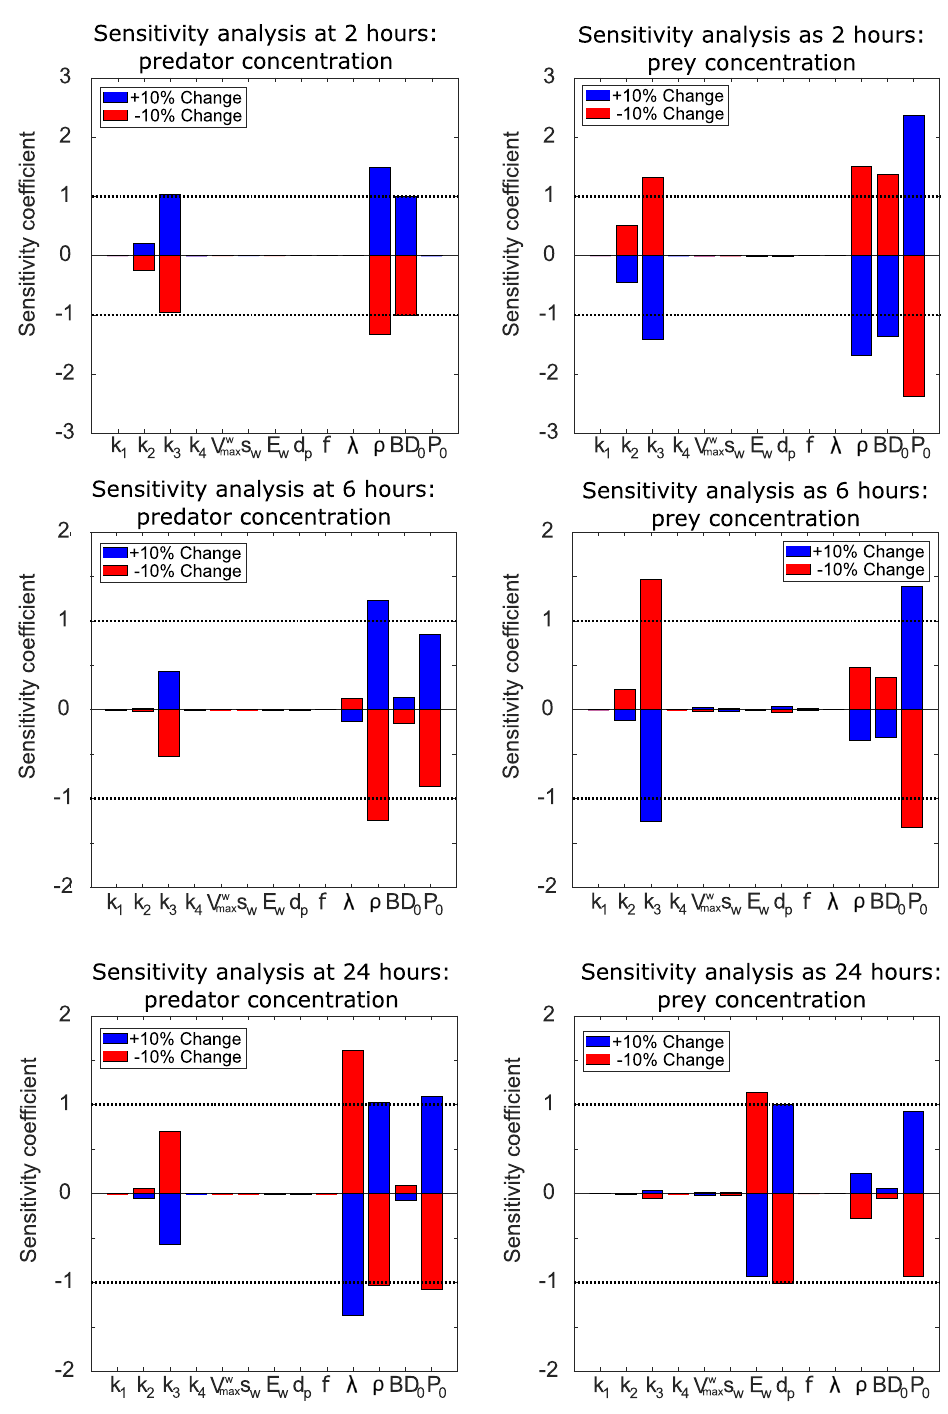
Figure 3. One-at-a-time sensitivity analysis of a ± 10% change in each parameter at three different time points. The variation in parameter sensitivity at different times reflects the different mechanisms dominating predator and prey interactions at those times. The sensitivity coefficient is scaled such that a value of ± 1 represents a ± 10% change in concentration as a result of a ± 10% change in parameter value. Parameter values detailed in Supplementary Table